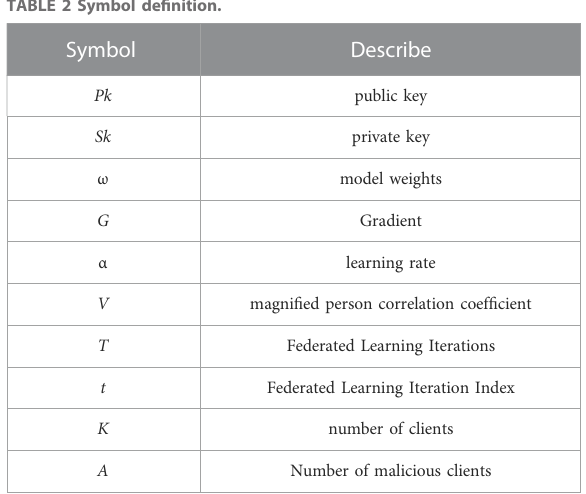
TABLE 2 Symbol de fi